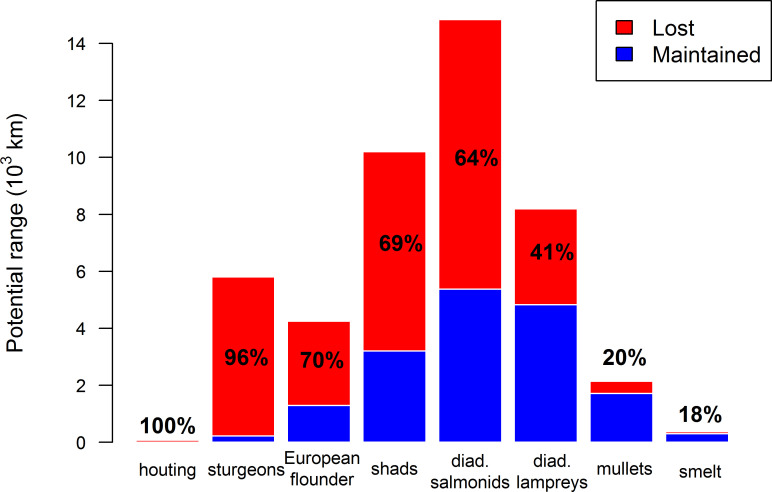
Maintained and lost potential distribution ranges of the French river system per taxon.The potential distribution range is represented in thousands of kilometers. The proportions of lost river length and maintained river length are represented in red and blue respectively and the percentage of lost length is displayed for each taxon.